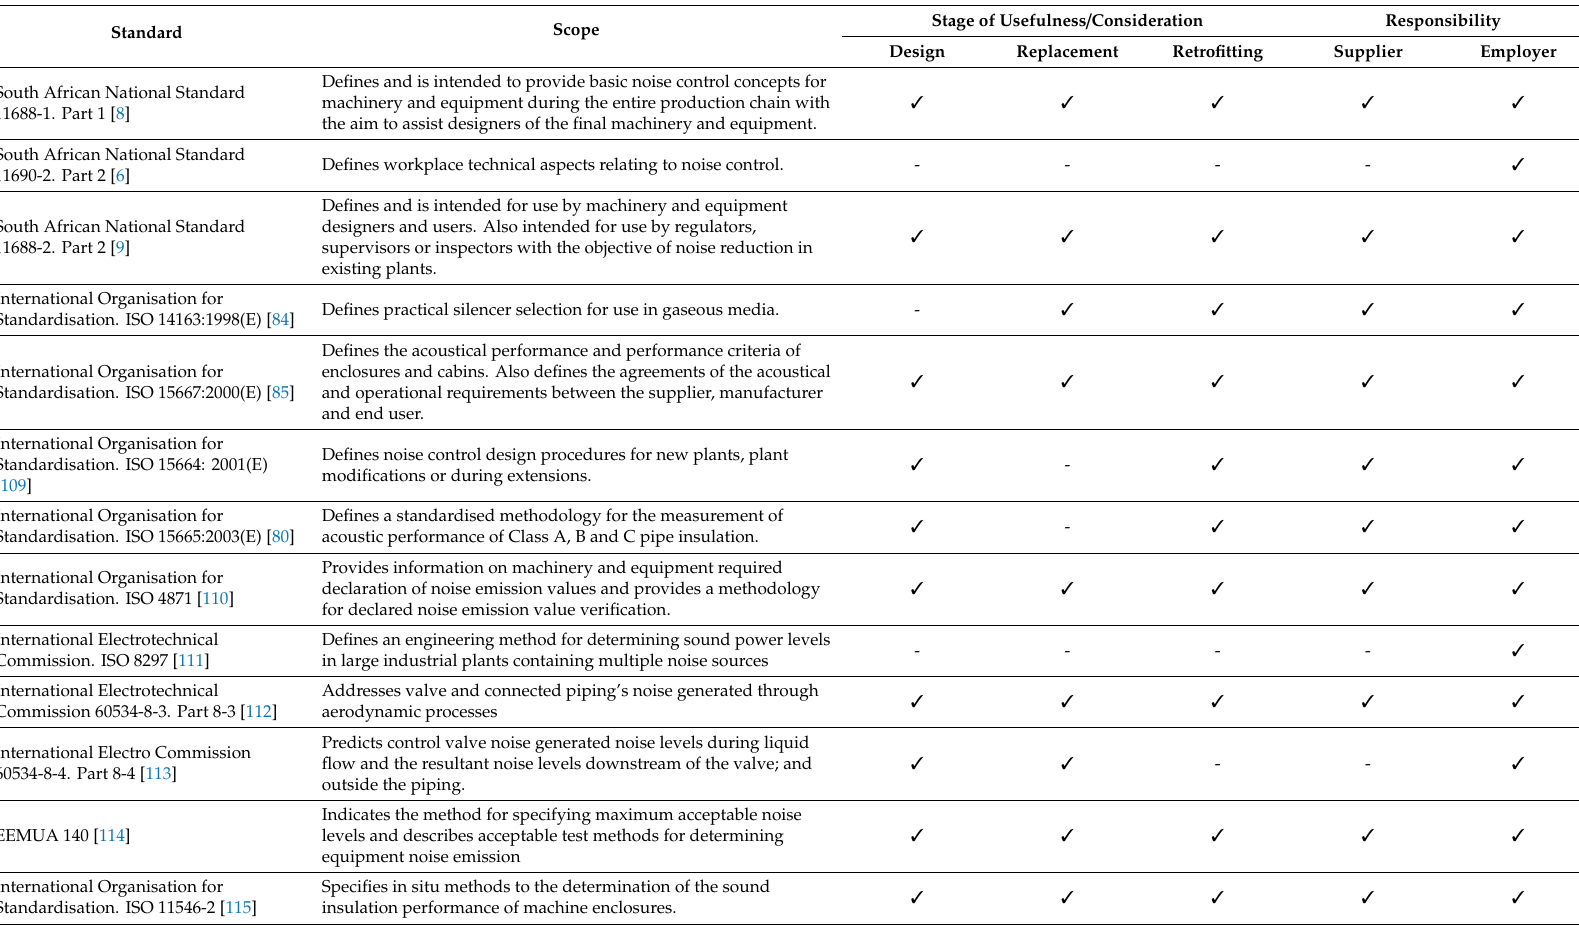
Stage of Usefulness / Consideration Responsibility Design Replacement Retrofitting Supplier Employer